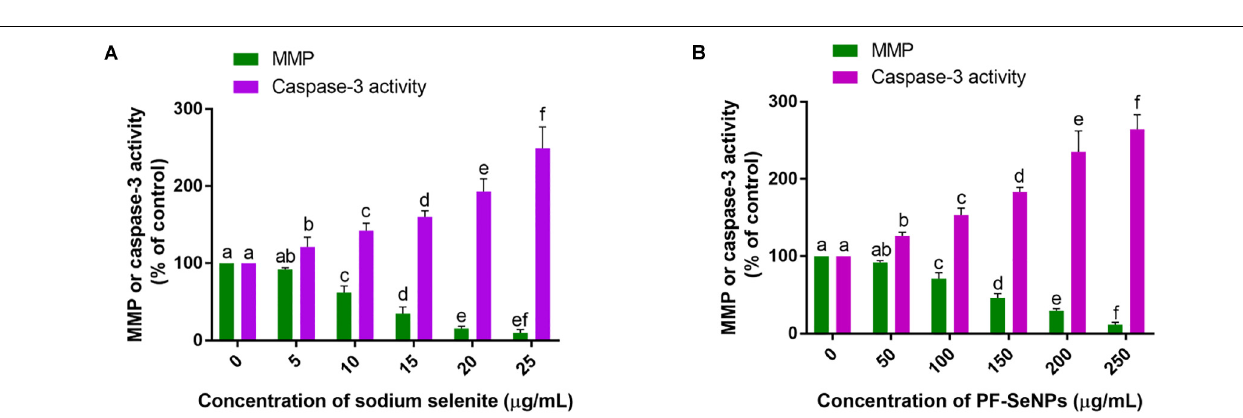
Frontiers in Microbiology |